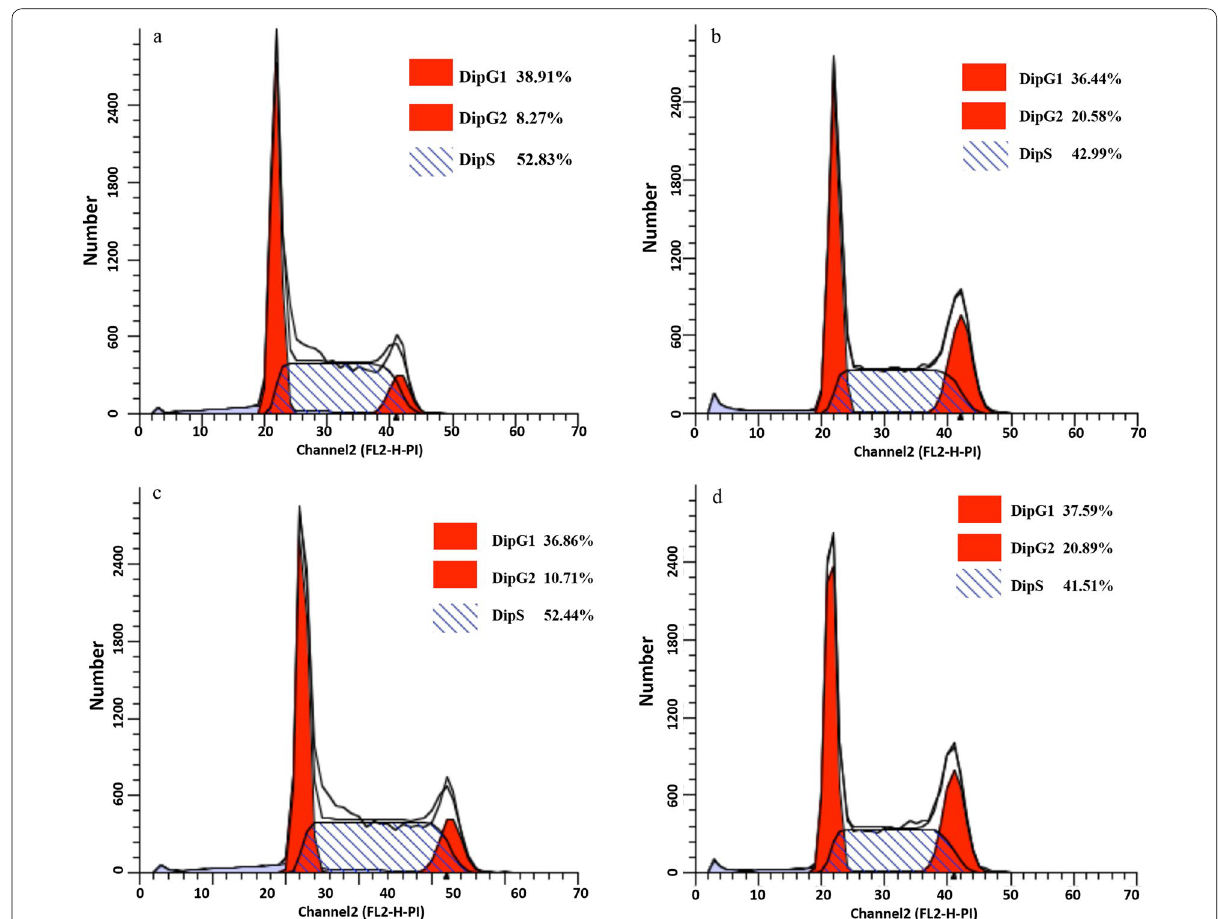
Fig. 2 Flow cytometry analysis on the cell cycle of K562. In the treatment group, cells in S phase decreased significantly and increased in G2/M